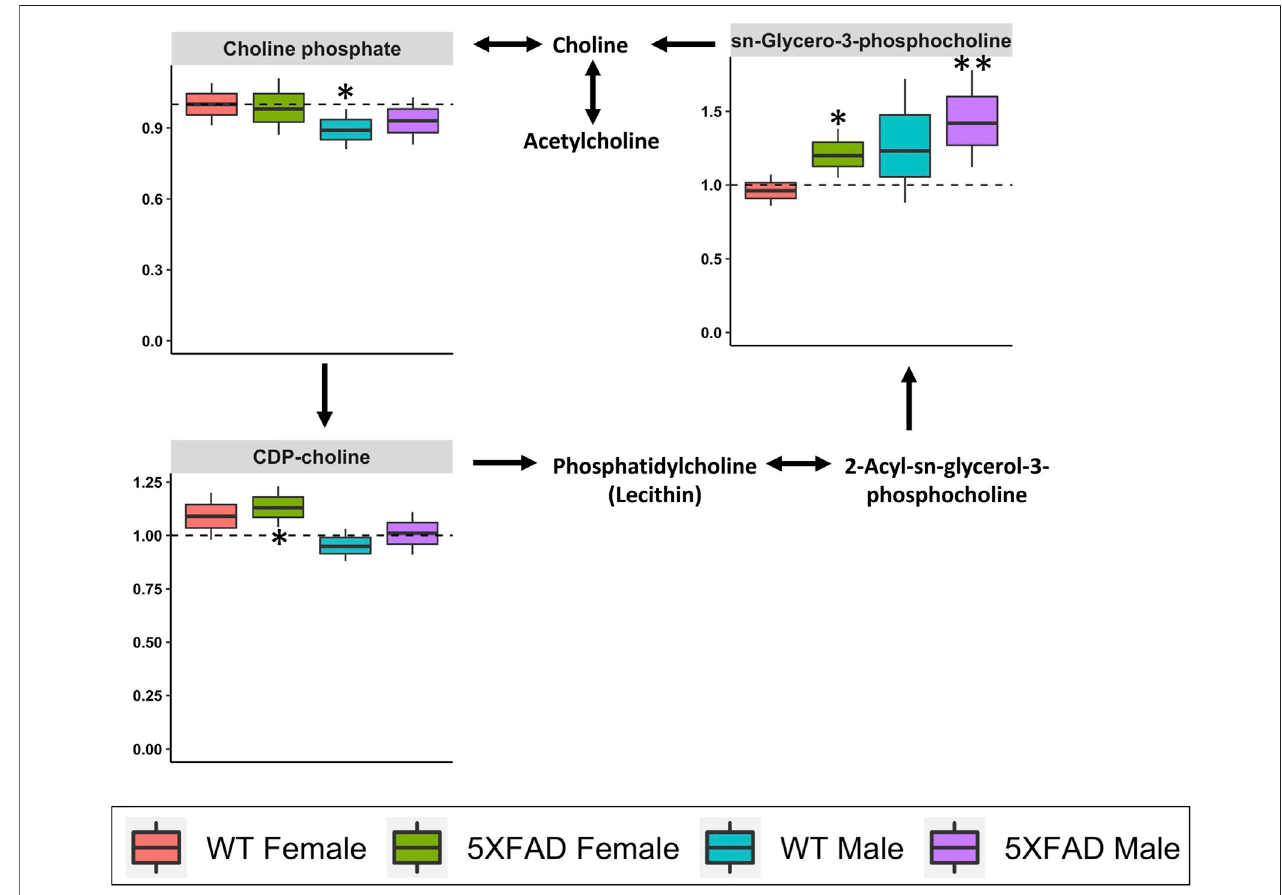
FIGURE 9 | Fold changes in cortical metabolites related to glycerophospholipid metabolism in male and female 5xFAD or wild-type (WT) mice following treatment with CAW (500 mg/kg) compared to sex- and genotype-matched untreated controls. * p < 0.05, ** p < 0.005, *** p < 0.001.